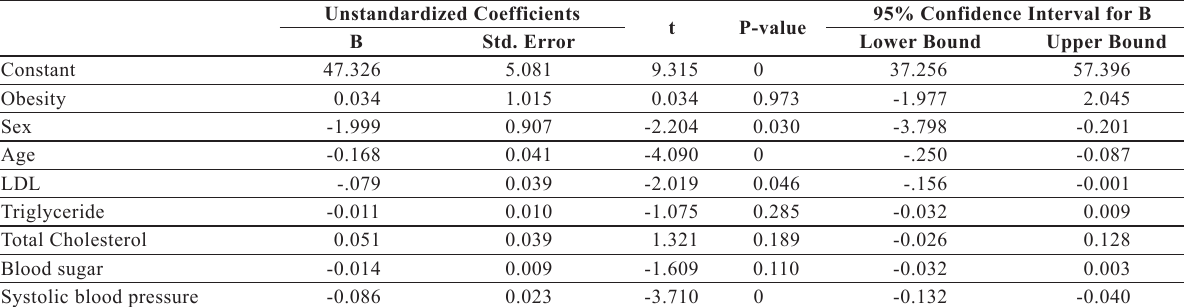
Table 3. Association of MoCA score and obesity adjusted for baseline Unstandardized Coefficients